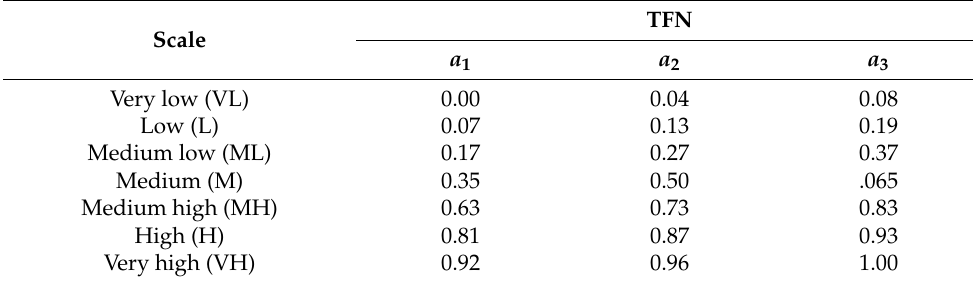
Table 2. Linguistic measurement scale.